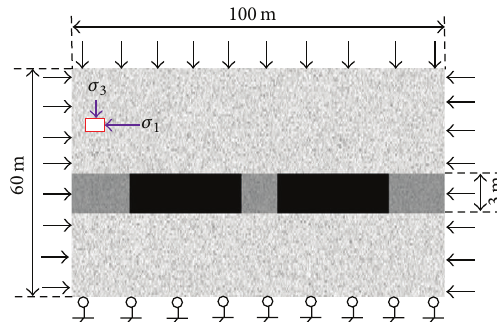
Figure 2: Numerical model and boundary condition.